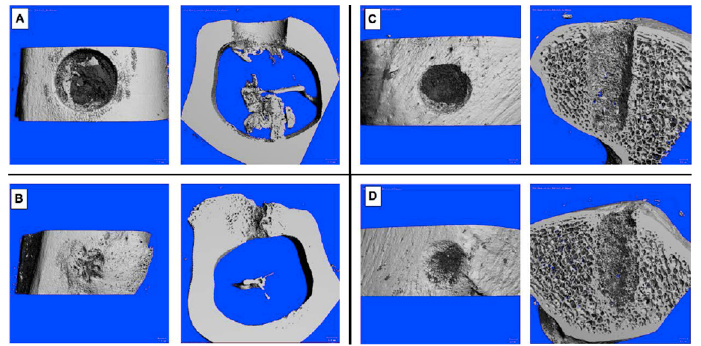
Figure 1 . Exemplary drill hole defects after three ( A , C ) and nine weeks ( B , D ). ( A , B ) diaphyseal defects, filled with gentamicin ‐ loaded DBM, ( C , D ) metaphyseal defects, filled with DBM.